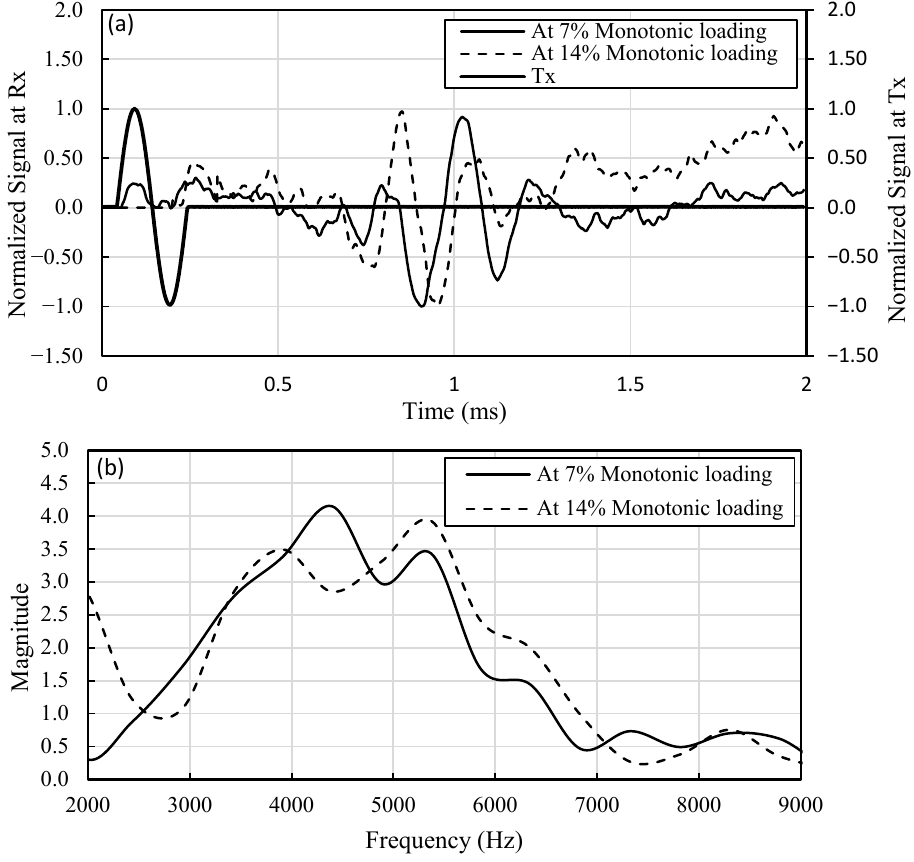
Figure 6. ( a ) Time histories at the bender element (BE) receiver (Rx), and ( b ) Fourier spectra of receiver signals. Tx corresponds to the transmitter (trigger) signal.